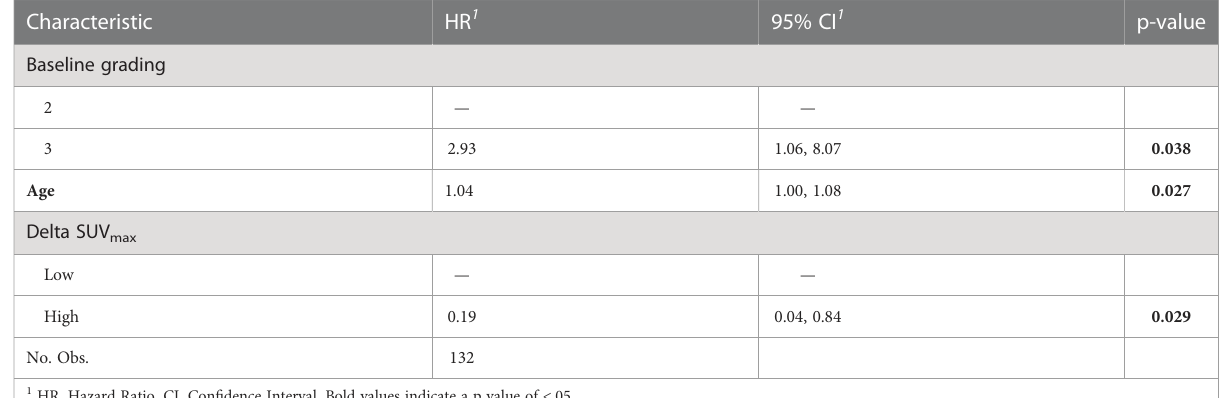
TABLE 6 Multivariable Cox proportional hazard model of the clinicopathological characteristics and metabolic parameters for OS.